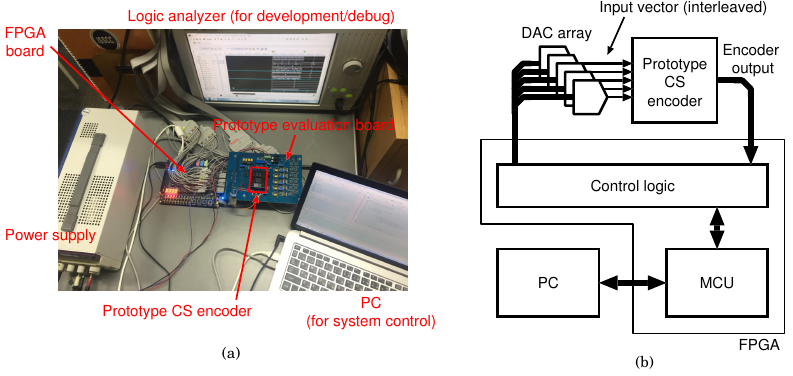
Figure 15. ( a ) Evaluation system for the prototype CS encoder and ( b ) its block